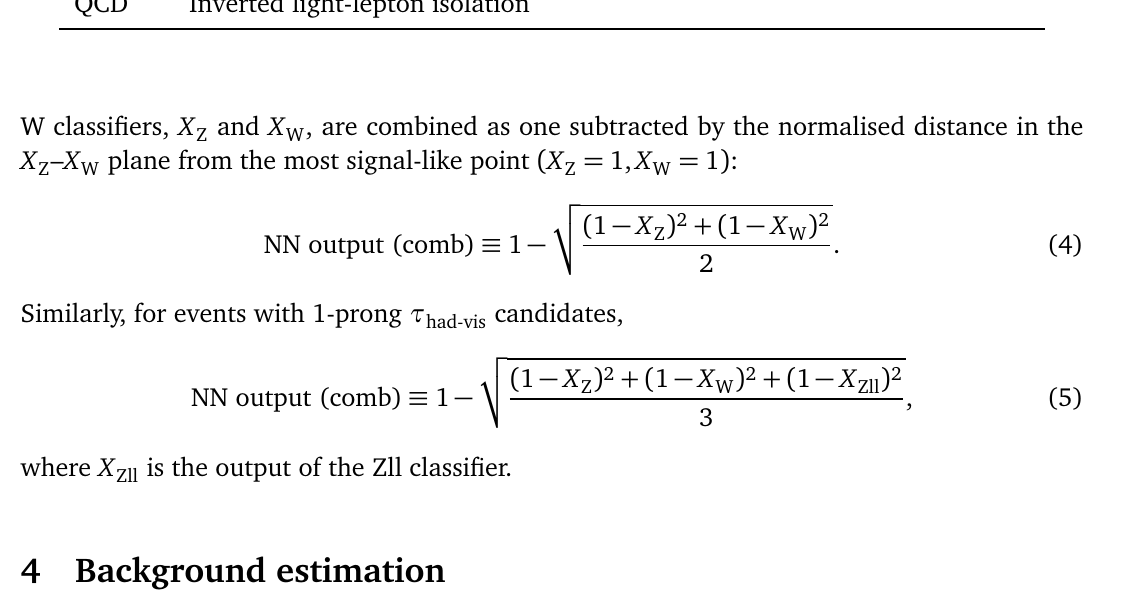
Inverted light-lepton